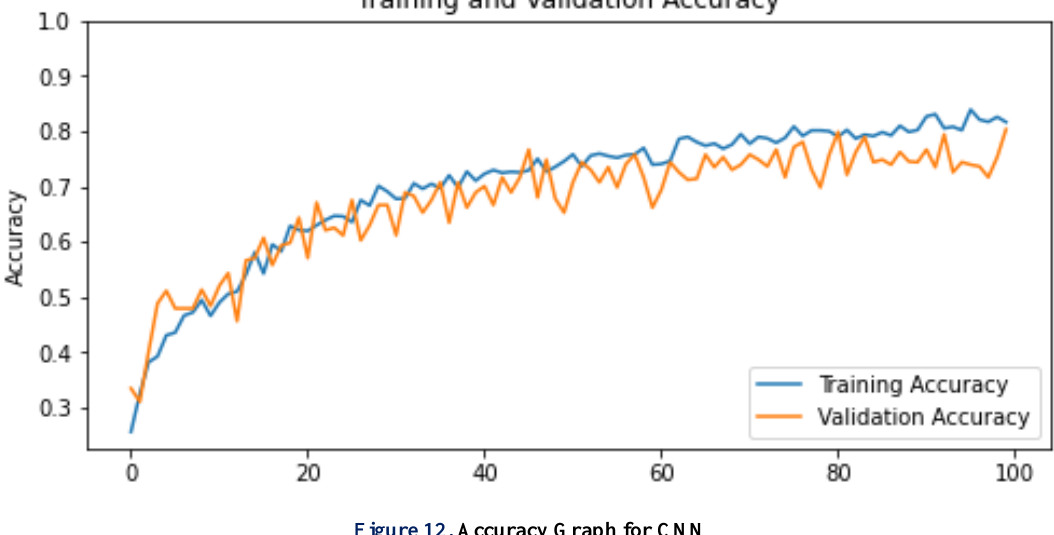
Figure 12. Accuracy Graph for